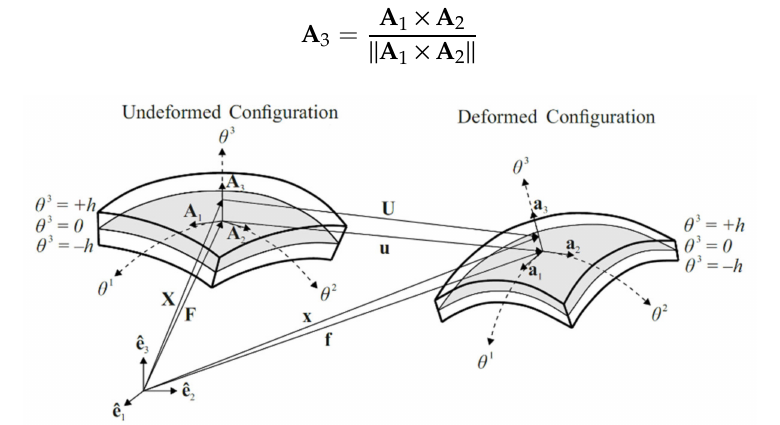
Figure 2. Undeformed and deformed configurations of the shell